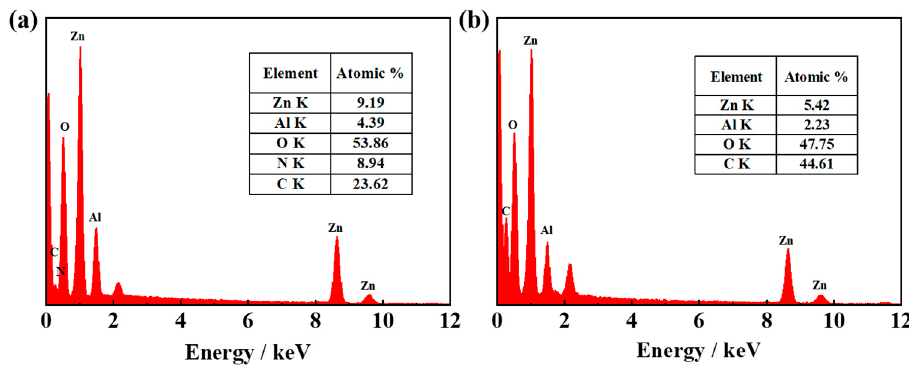
Figure 3. EDS results of ( a ) LDH and ( b ) GA − LDH.